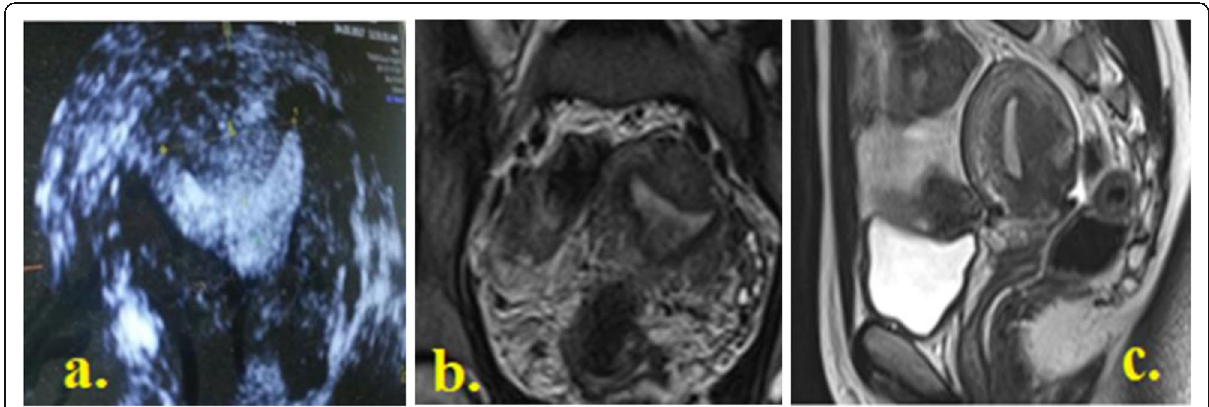
Fig. 5 A 28-year-old married female patient complaining of primary infertility. a Dysmorphic uterus (class U1) by 3DTVS showing fundal internal indentation < 50% of uterine wall thickness. b MRI coronal T2 showing fundal low signal intensity irregular areas indenting endometrial cavity. c Sagittal T2WI showing thick junctional zone exceeding 12 mm (uterine adenomyosis), class U0 according to MRI